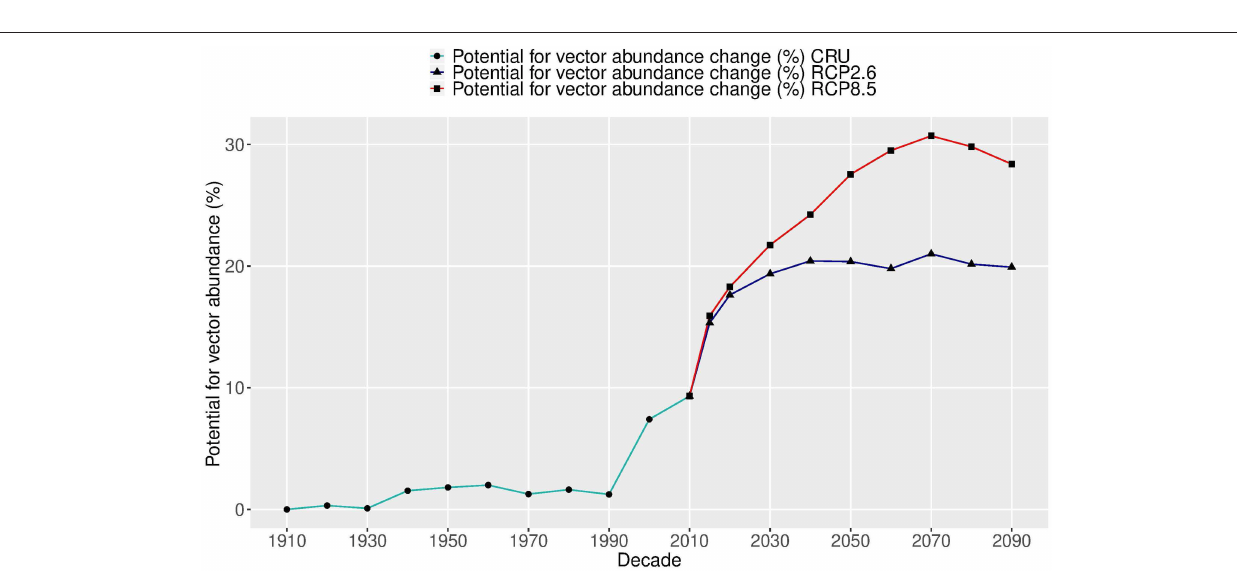
Our study illustrates not only the global distribution of